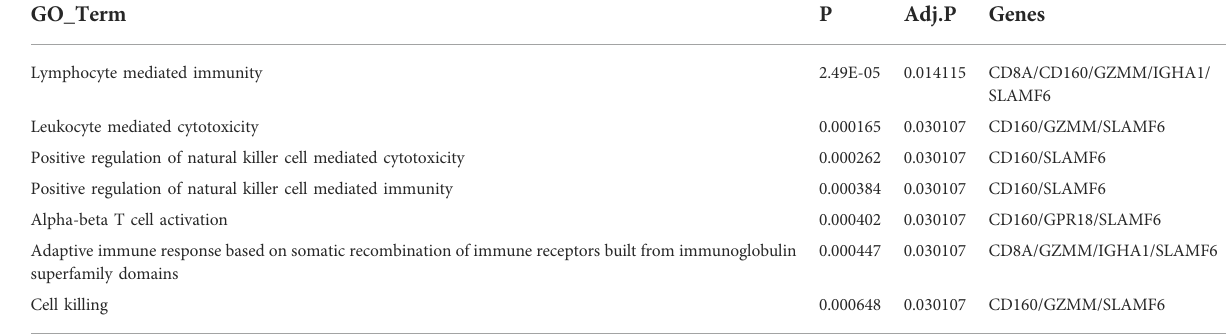
TABLE 3 GO (BP) enrichment results of the 21 selected genes.